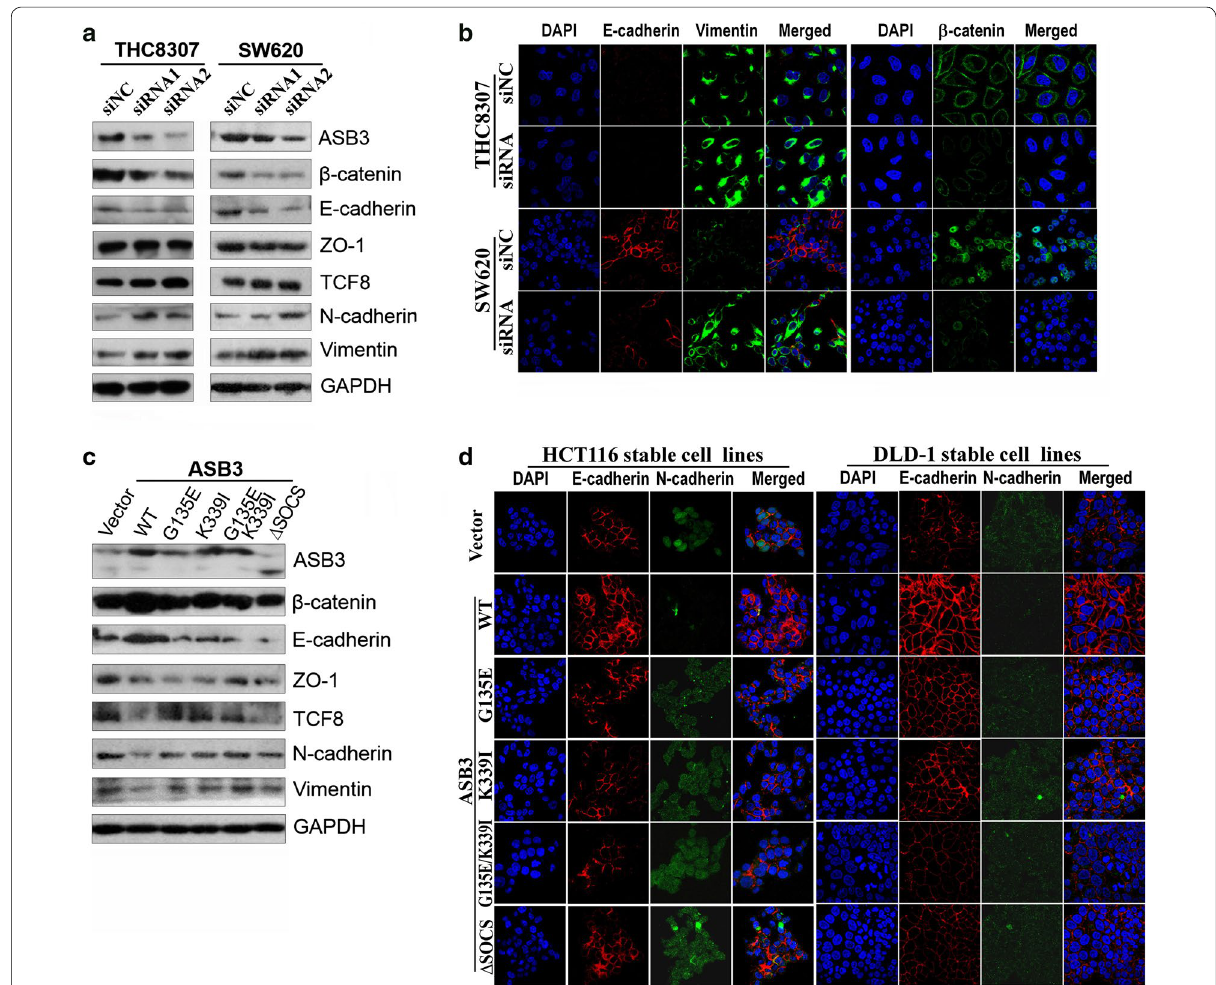
Fig. 5 ASB3 inhibits the epithelial‑mesenchymal transition (EMT) of CRC cells. After THC8307 and SW620 cells were transiently transfected with siRNAs to knockdown ASB3 expression for 48 h, EMT markers were detected with Western blotting ( a ) and immunofluorescence assays ( b ), whereas EMT markers were detected with Western blotting ( c ) and immunofluorescence assays ( d ) in HCT116 or DLD‑1 cells stably transfected with ASB3 cDNA or its